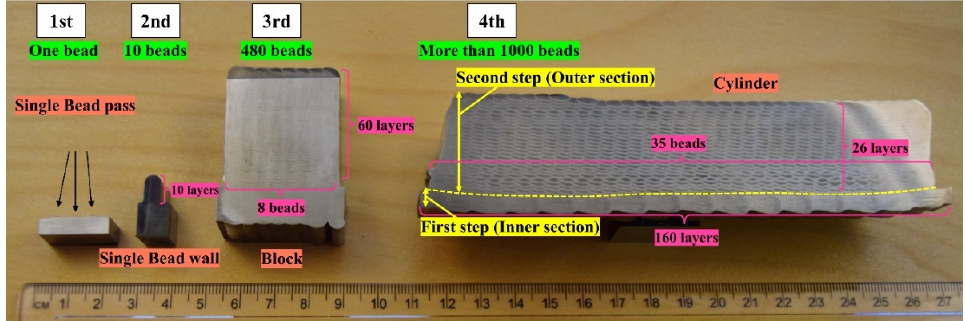
Figure 4. Cross-sections of single-bead pass, single-bead wall, block, and cylinder. Increase in the number of deposited beads from the first stage to the fourth one. number of deposited beads from the first stage to the fourth